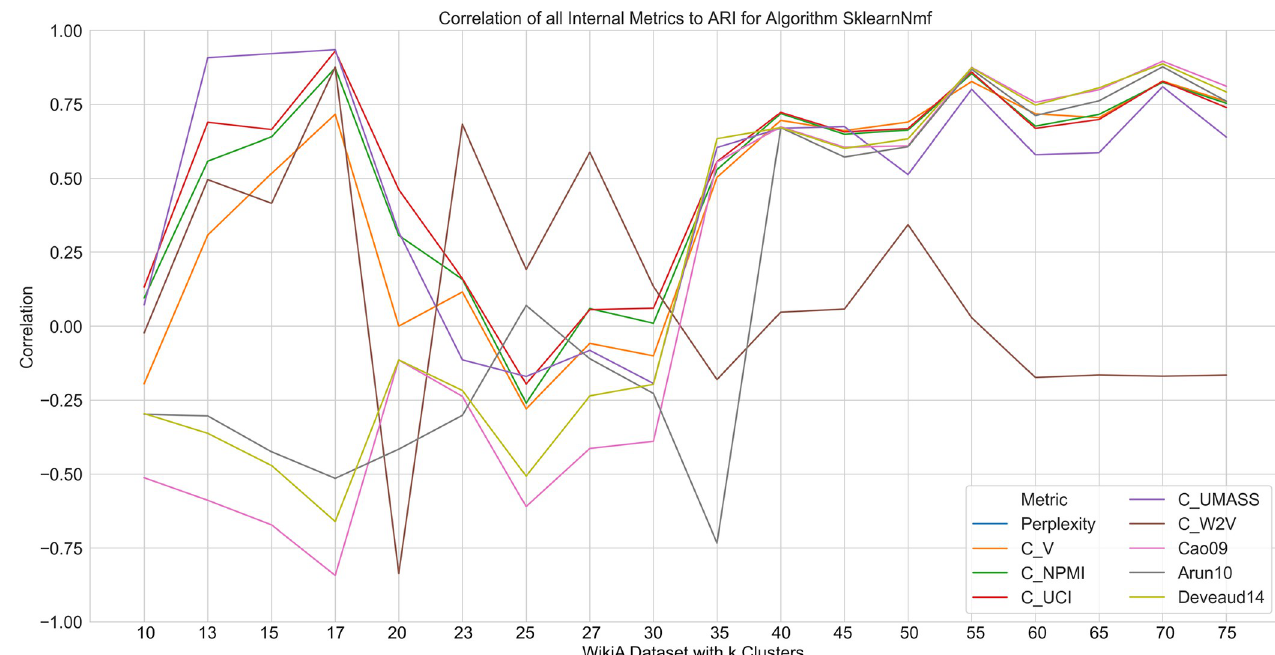
Fig 6. Correlation of all internal metrics to ARI for NMF on the WikiA dataset series.